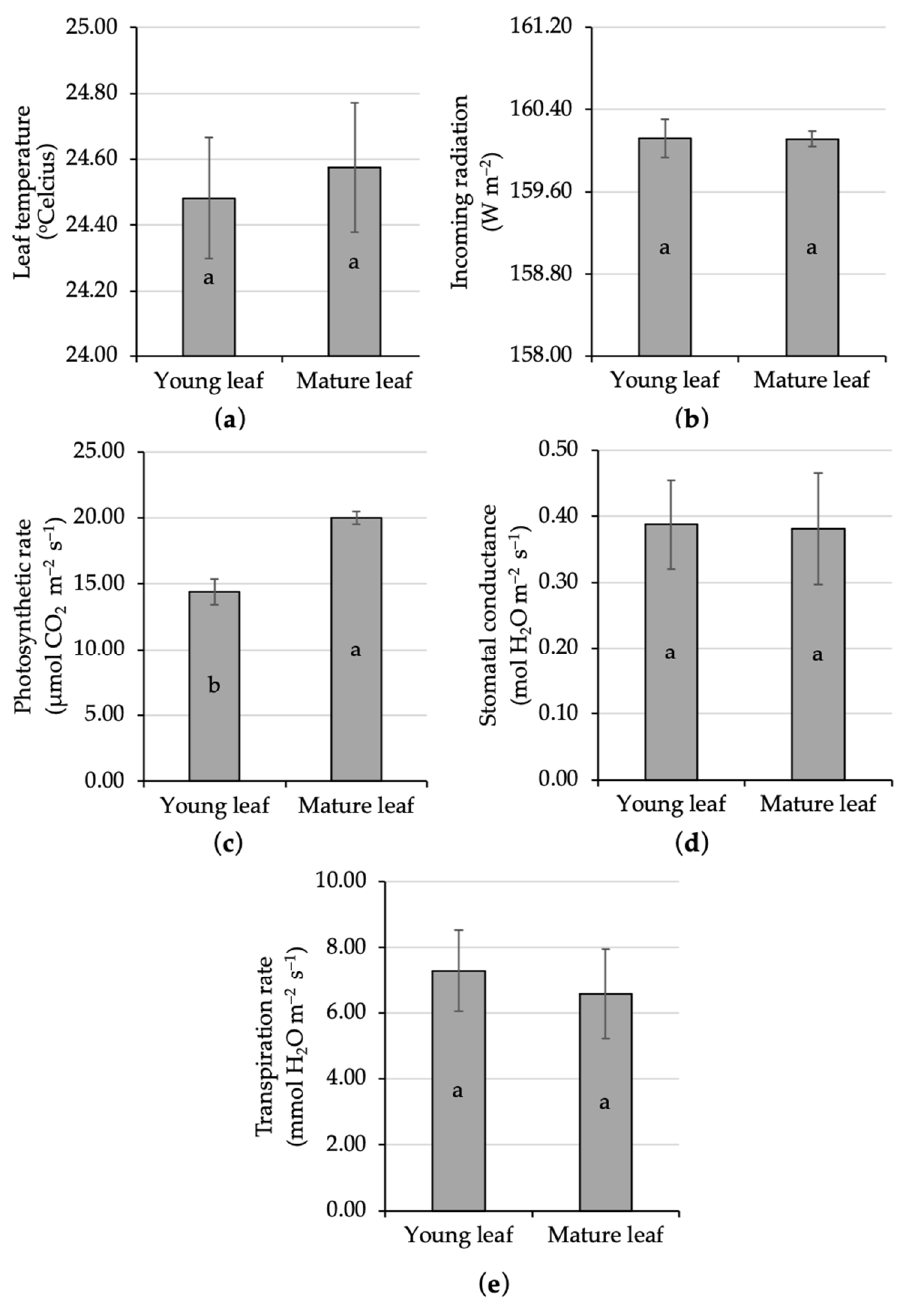
Figure 2. Comparative analysis of the ecophysiological characters of young and mature kaffir lime leaves; namely, leaf temperature ( a ), incoming radiation ( b ), photosynthetic rate ( c ), stomatal conductance ( d ), and transpiration rate ( e ). Different letters inside the rectangular bar indicate a significant difference based on the LSD test at α 5%; the error bar represents the standard deviation.